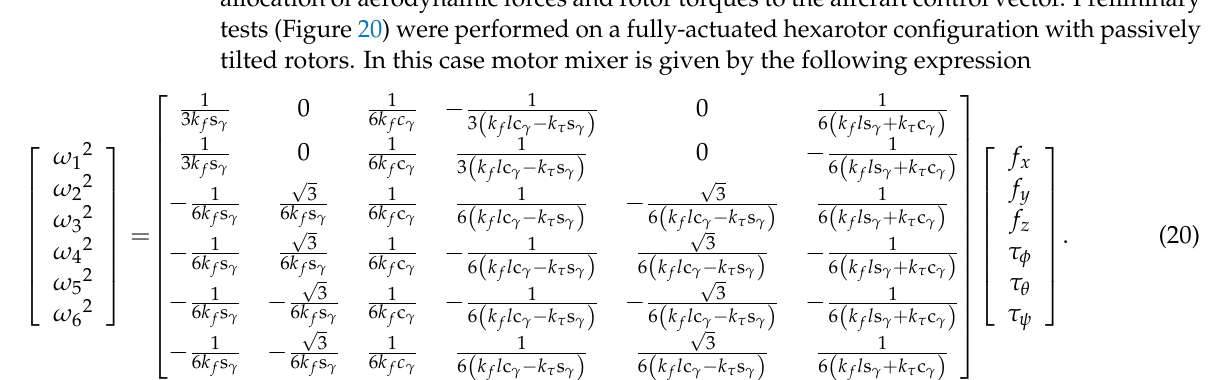
Figure 19. Experimental testing of attitude control on flat hexarotor configuration (FX6).